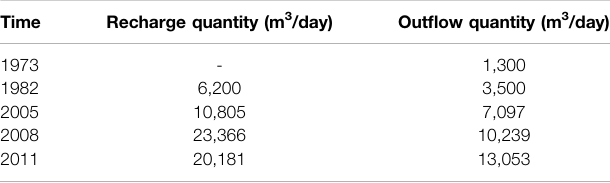
TABLE 2| Statistical tableof thermal reservoir thickness in main movement zones of geothermal